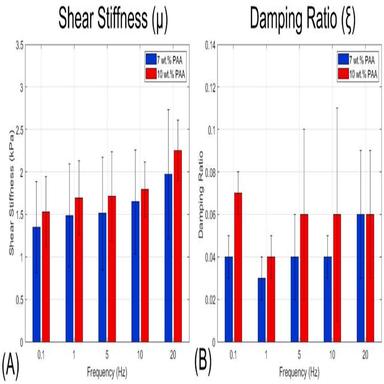
(A) Shear stiffness (μ) and (B) damping ratio (ξ) of the swelled polyacrylamide (PAA) hydrogel compositions obtained from rheological measurements over a frequency range of 0–20 Hz. A minimum of 7 samples were tested for each composition.